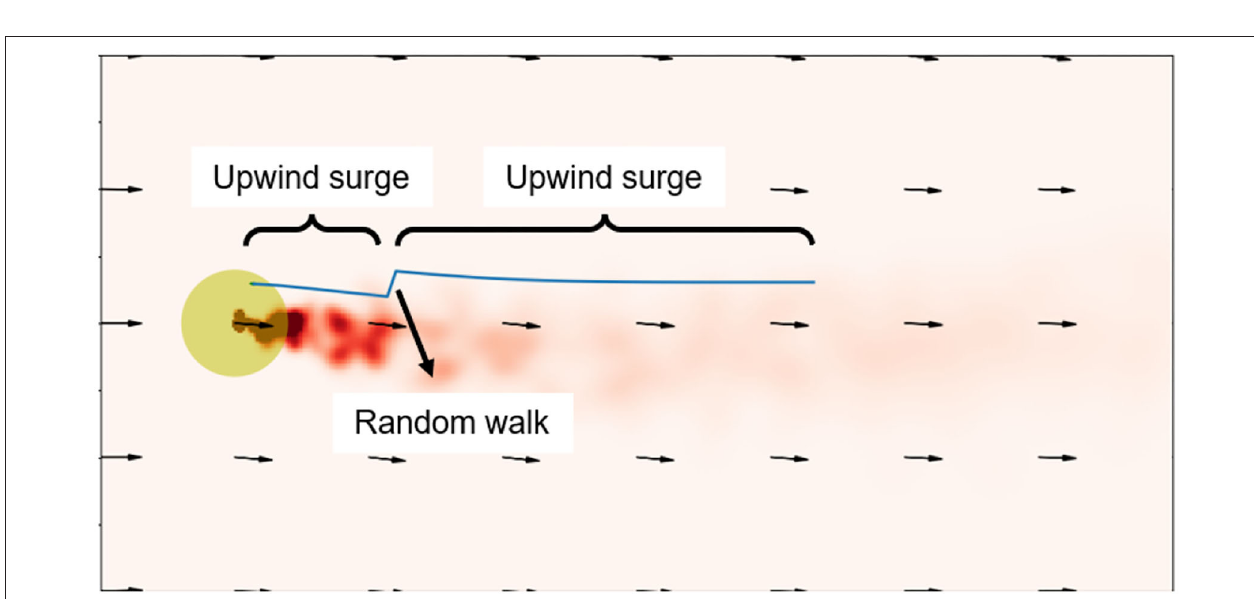
FIGURE 5 | Performance evaluation results of the three controllers in the Monte Carlo tests. (A) Success rate, (B) is the number of searching steps, and (C) is the distance overhead. Model 1: the Fuzzy Lévy Taxis algorithm used in the supervised training; Models 2–20: the trained MCOTSK model after every 20 reinforced training episodes (from 0 episodes to 360 episodes); Model 21: the MCOTSK model trained with RL only.